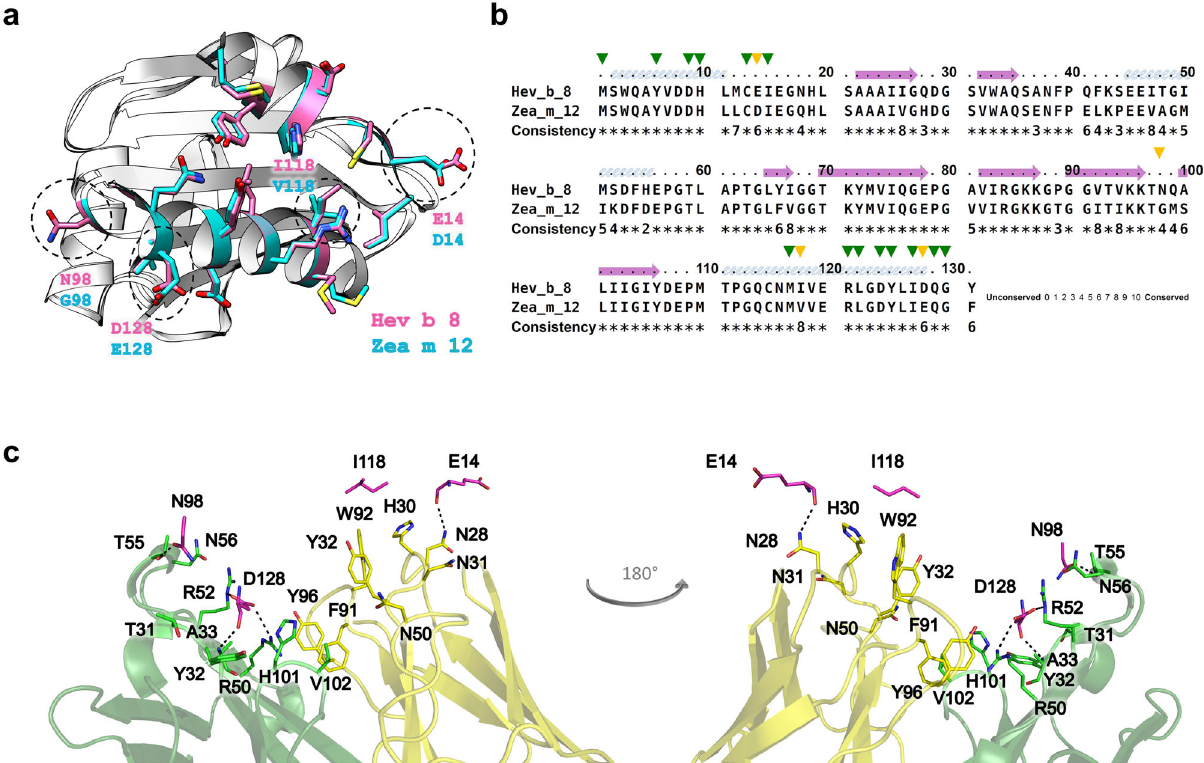
Fig. 7 Generating cross-reactivity. a Ribbon and stick models of rHev b 8 (pink) and rZea m 12 (cyan) pro fi lins (RMSD 0.307 Å). Different residues between both pro fi lins (E14, N98, I118, and D128) are circled in dotted lines; this epitope region is part of the polyproline binding site in pro fi lins. b Sequence alignment between rHev b 8 and rZea m 12, green arrows show conserved residues in the epitope, and yellow arrows show different residues. c Paratope residues of Fab/IgE 2F5 and the four residues in rHev b 8 that are different in rZea m 12 are displayed as sticks. rHev b 8 epitope residues are shown in pink, the Fab heavy chain residues in green, and the Fab light chain residues in yellow. Dotted lines indicate residues interactions.